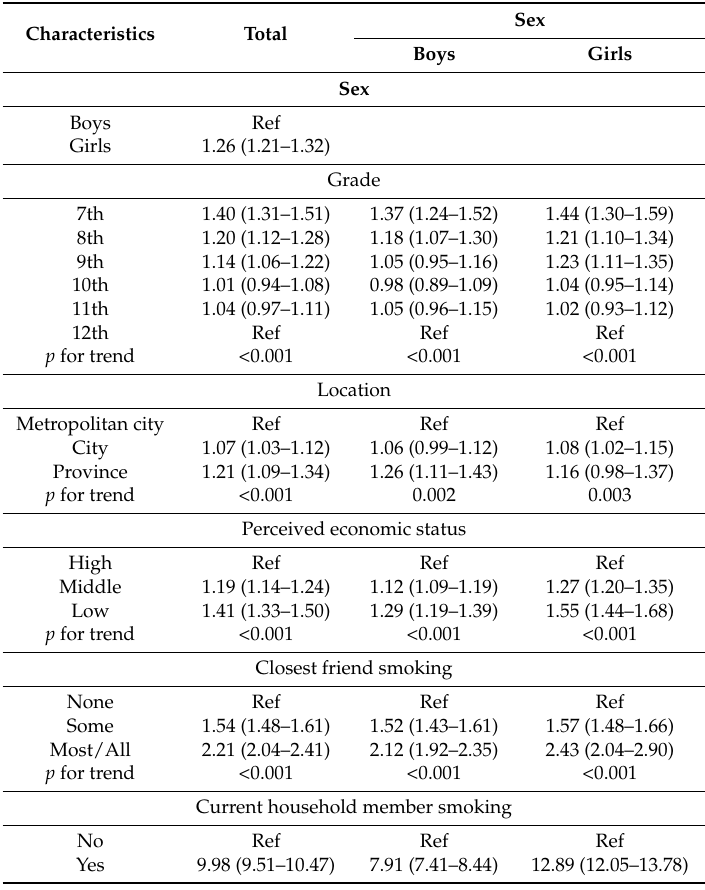
Table 2. Adjusted odds ratios a (95% confidence interval) for exposure to second-hand smoke at home.